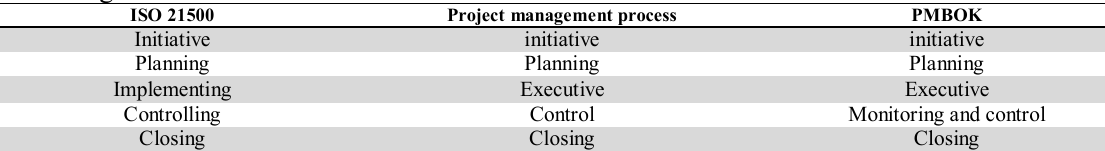
The findings of section